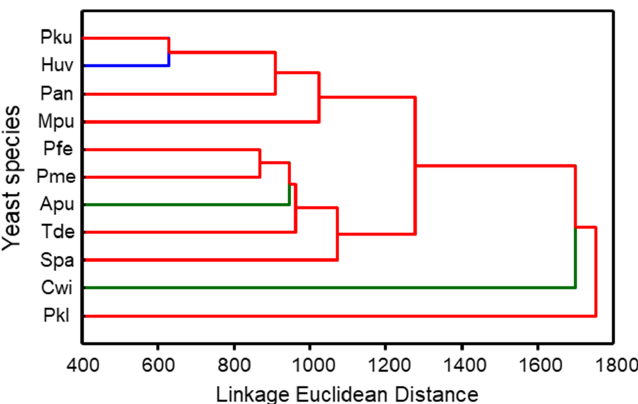
Figure 3. Dendrogram of odour blends sampled by SPME from the headspace of eleven yeast species. The dendrogram was obtained by cluster analysis based on Euclidean distance. The clustering was carried out based on the average of quantified volatile compounds from three different isolates per species. The different clusters were identified by visually evaluating the clustering. Pku— Pichia kudriavzevii , Pfe— P. fermentans , Pan— P. anomala , Pkl— P. kluyveri , Pme— P. membranifaciens , Spa— Saccharomyces paradoxus , Tde— Torulaspora delbrueckii , Mpu— Metschnikowia pulcherrima , Huv— Hanseniaspora uvarum , Apu— Aureobasidium pullulans , Cwi— Cryptococcus wieringae . Apu and Cwi yeasts are more common on unripe fruits and are represented by the green colour, Huv yeasts are the most common on medium-ripe and ripe fruits and are indicated by the blue colour, and the red colour represents yeasts, the most common on ripe